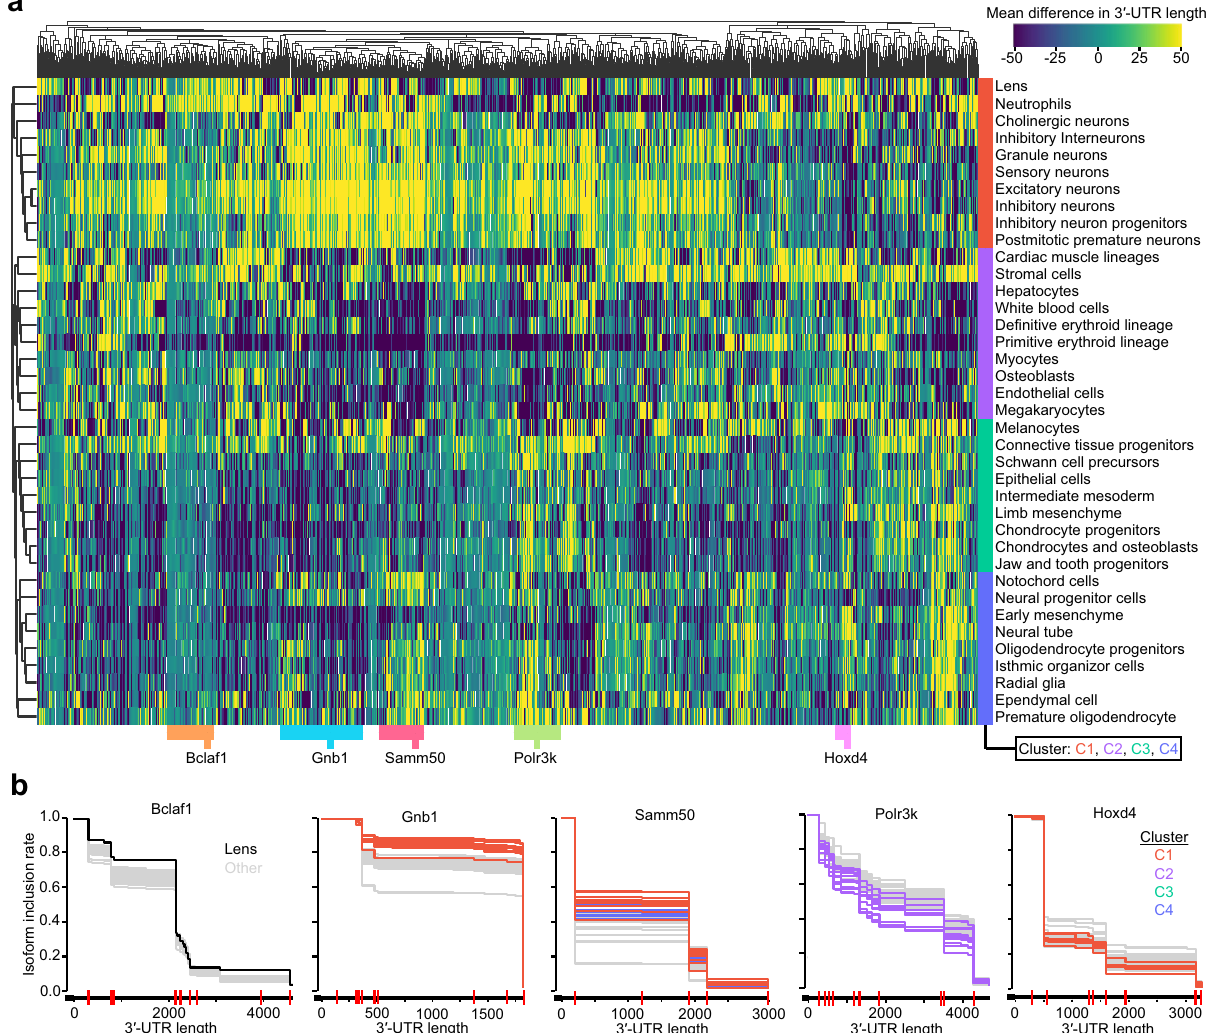
Fig. 5 Identi fi cation of distinct gene lengthening patterns and genes responsible for overall data trends across embryonic ages. a Heatmap of mean differences in 3 ′ -UTR lengths for 1078 genes with signi fi cant differences in PAS usage across cell types derived from 38 t-SNE clusters. Heatmap is column-centered and clustered in both rows and columns by Pearson correlation as a distance metric. Row colors indicate the four dominant cell-type clusters. Column colors indicate fi ve representative clusters chosen from the dendrogram above. b IIR plots for fi ve genes among the representative clusters shown in ( a ), and colored by either individual cell types or cell-type clusters shown in ( a ). Gray lines allude to all other cell types. Vertical red lines along the 3 ′ -UTR indicate PASs that are signi fi cantly different between cell types by the χ 2 test ( P < 0.05). See also Supplementary Fig. 6 for clustering according to differences in entropy. See also Supplementary Data 5 for a table of read counts associated with each PAS for each gene and cell